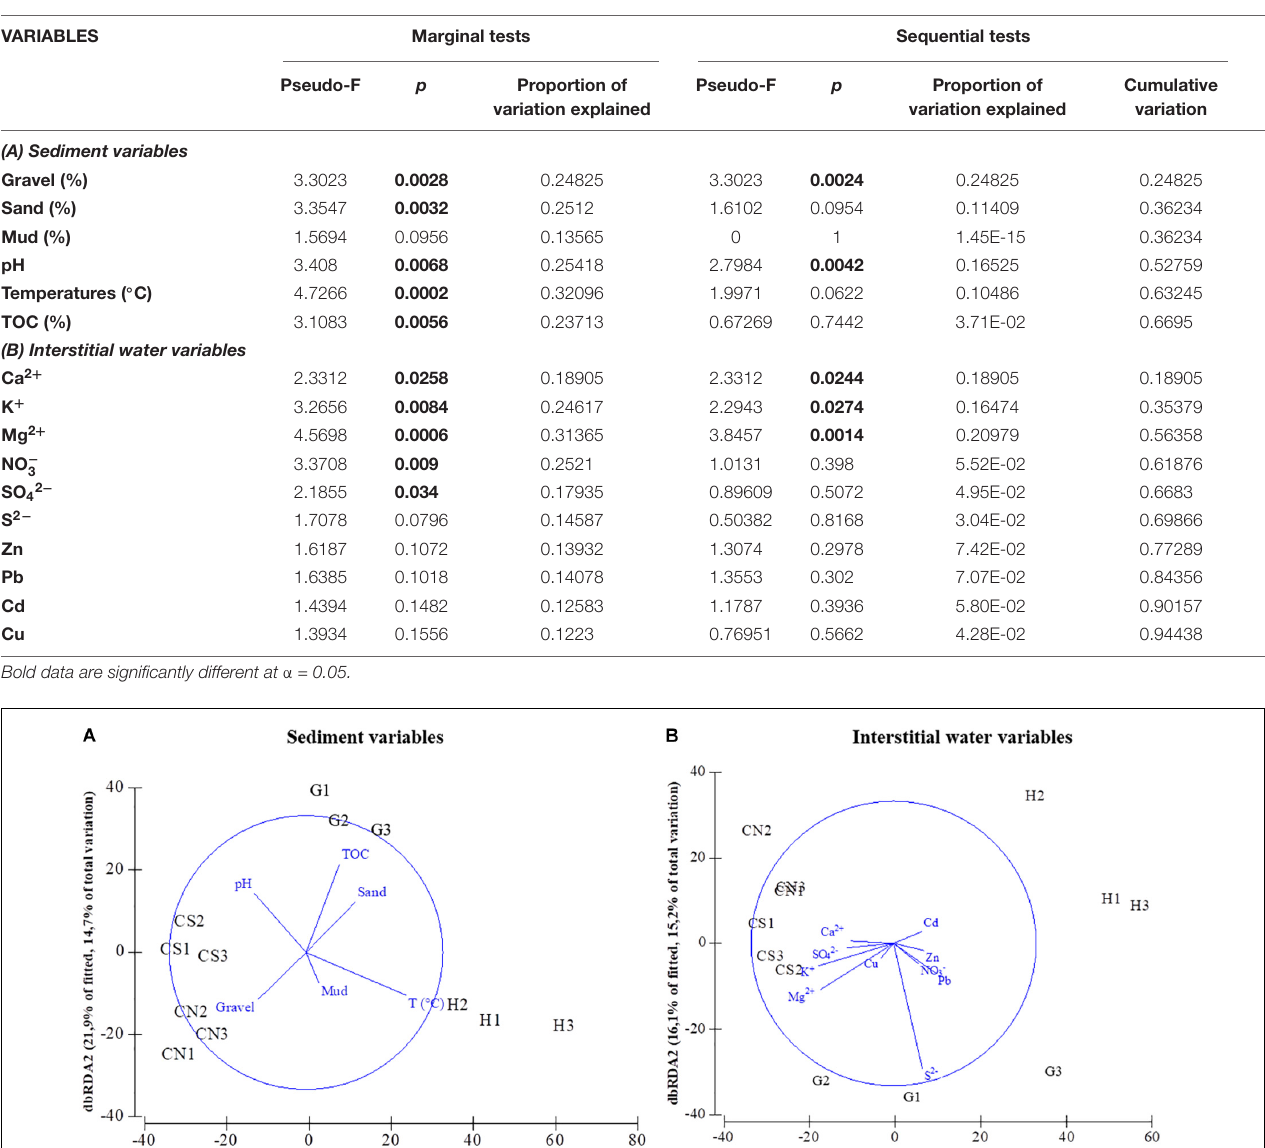
TABLE 8 | DistLM results comparing benthic community data and environmental variables (A,B) .